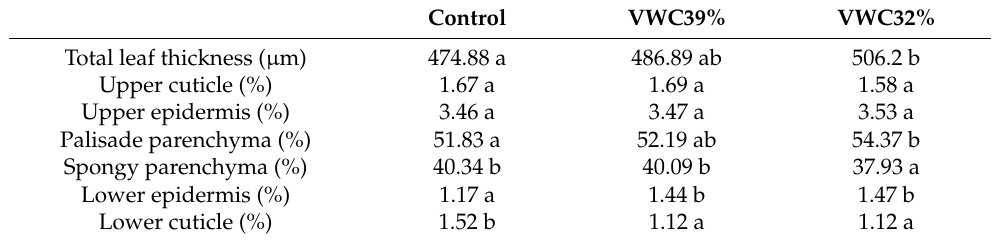
Table 4. Thickness of the cross-sectional layer of Hebe leaves ( µ m) and percentage of each component in response to three different volumetric water contents (VWCs) after 152 days: control (VWC 49.28%), VWC39% (VWC 38.44%), and VWC32% (VWC 32.16%).